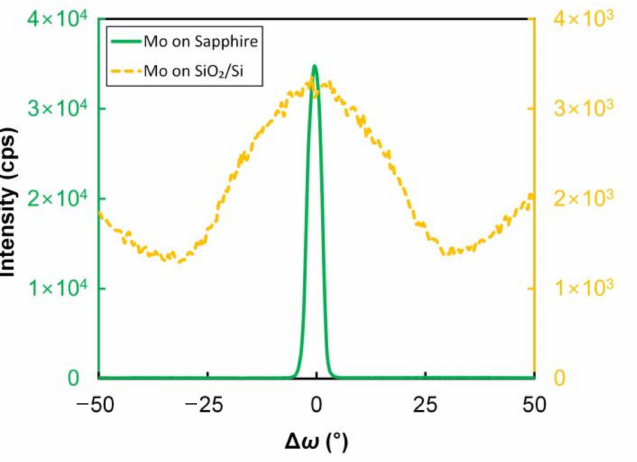
Figure 3. Comparison of the XRD rocking curves of Mo (110) on the sapphire and SiO 2 /Si substrates. The in-plane orientational relationship between the AlN thin film and sapphire